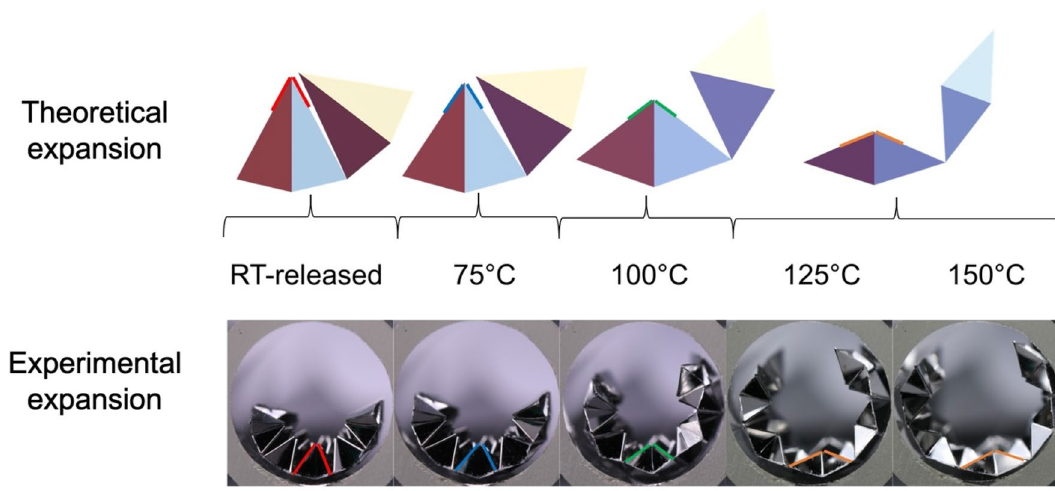
Figure 5. Expansion of devices on heating when expanded on heating theory vs. experimental. For the theory, only two cells within in overall tube are displayed. The theory cells are chosen, as indicated, to match the representative angles in the cells of the experiment. The image is made using Inkscape (V 0.92, https:// inksc ape. org/) and Mathematica (V 12, https:// www. wolfr am. com/ mathe